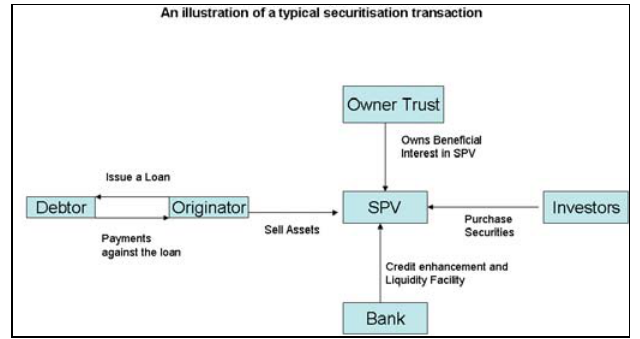
Figure 1: A typical securitisation transaction Source: Deloitte